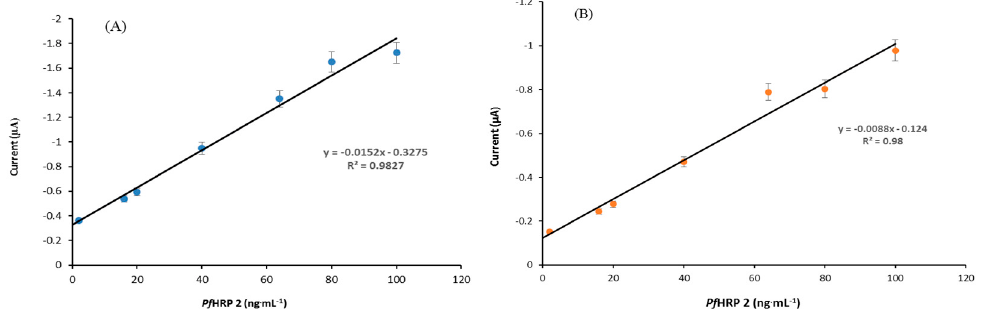
Figure 5. Linear regression analysis of the chronoamperometric response of Pf HRP 2 detection in buffer (PBS, 0.01M, pH 7.4, spiked with 1–100 ng·mL − 1 Pf HRP 2) ( A ) and 100% serum samples (spiked with 1–100 ng·mL − 1 Pf HRP 2) (B) on a JD2 sensor. Measurements were conducted at − 0.2 V.